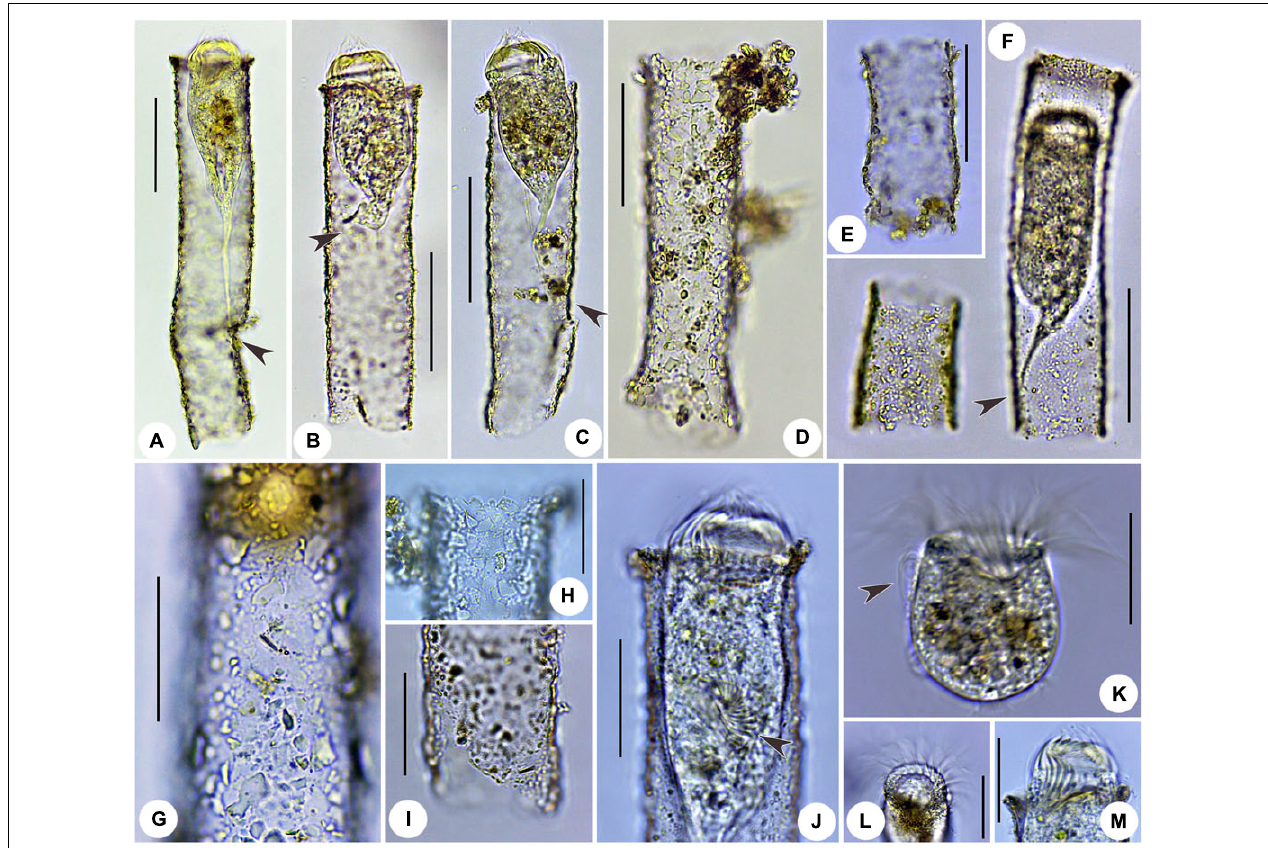
FIGURE 2 | Leprotintinnus nordqvisti in vivo . (A–F) Showing the variability of loricae shape and size, the arrows indicate the positions where the cell is properly attached to the inner wall of the lorica via the peduncle. (G) Lorica wall with numerous mineral particles. (H) Slightly flared oral marginal. (I) Broken aboral end opening. (J) Not fully contracted specimen, arrowhead denotes the oral primordium. (K) Cell proper out of the lorica, arrowhead denotes the elongated anteriormost cilia. (L) Oblique top view showing the oral membranelles. (M) Ventral view of cell showing the oral cavity. Scale bars: 50 µ m (A–F) , 30 µ m (G–M)